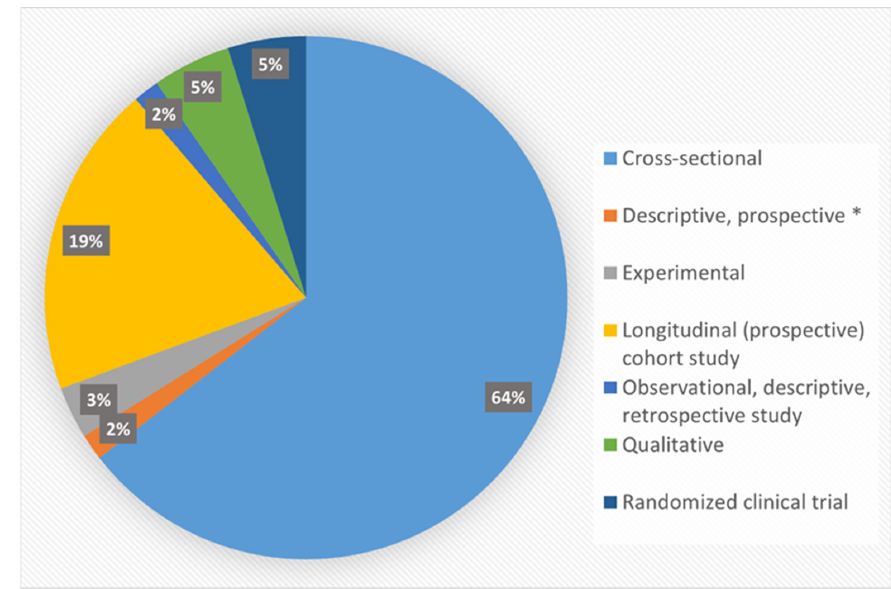
Figure 2. Distribution of included studies by study designs (Note: * Qualitative study). Table 3. Summary of included studies that used non-clinical tools for risk assessment in the general young adult popula- tion.